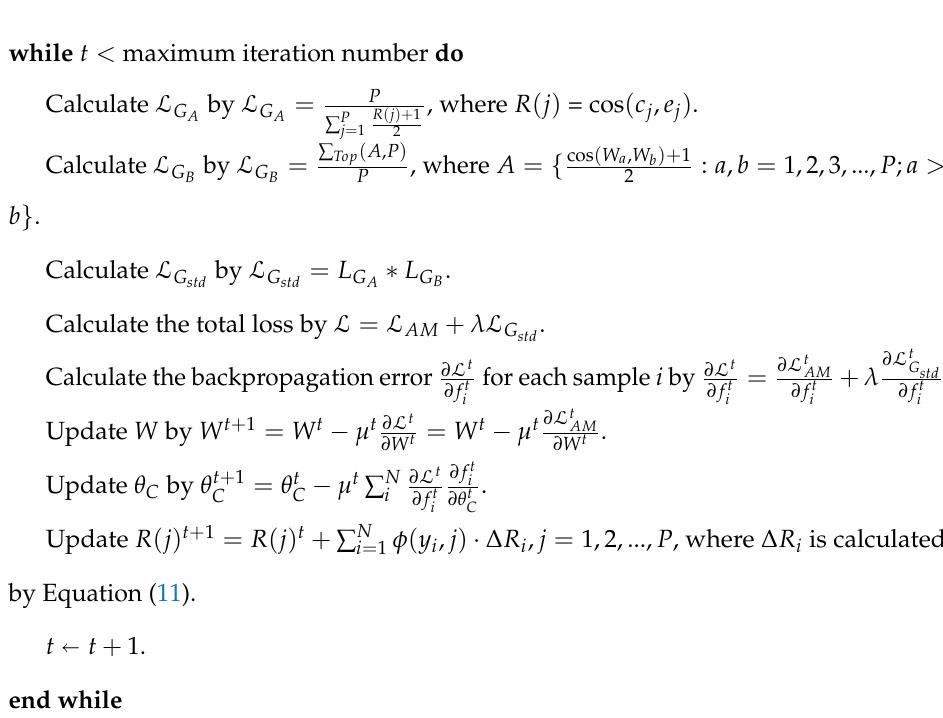
Algorithm 1 Learning algorithm in the CNNs with the proposed Gico